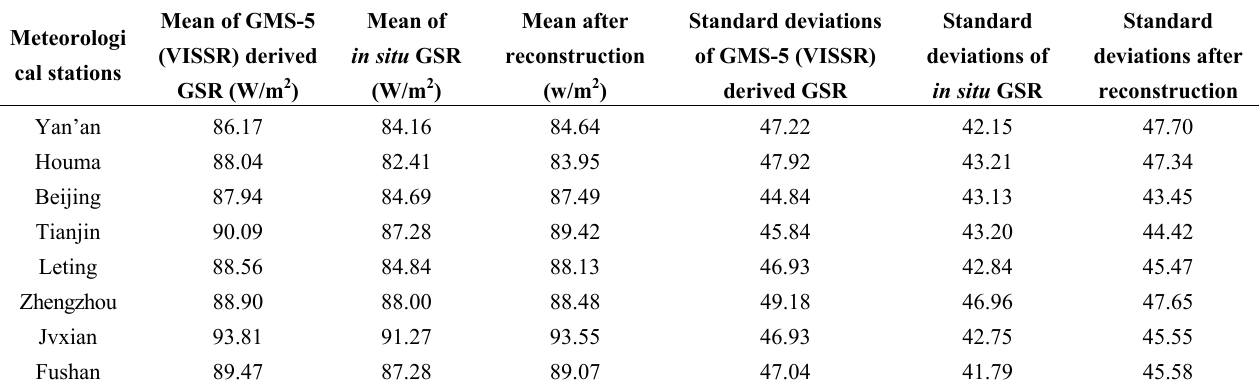
3. Comparison of the remotely sensed solar radiation data before